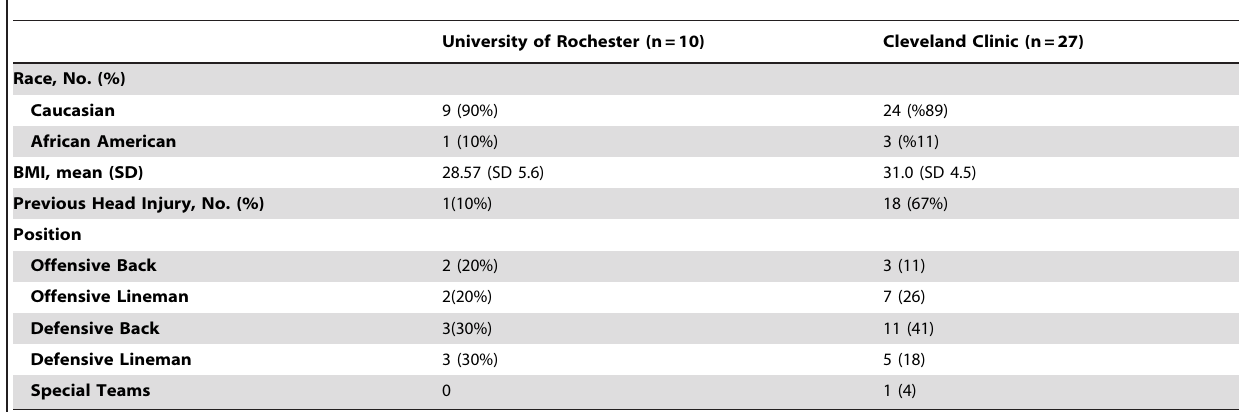
Table 1. Demographics and characteristics of players enrolled for the